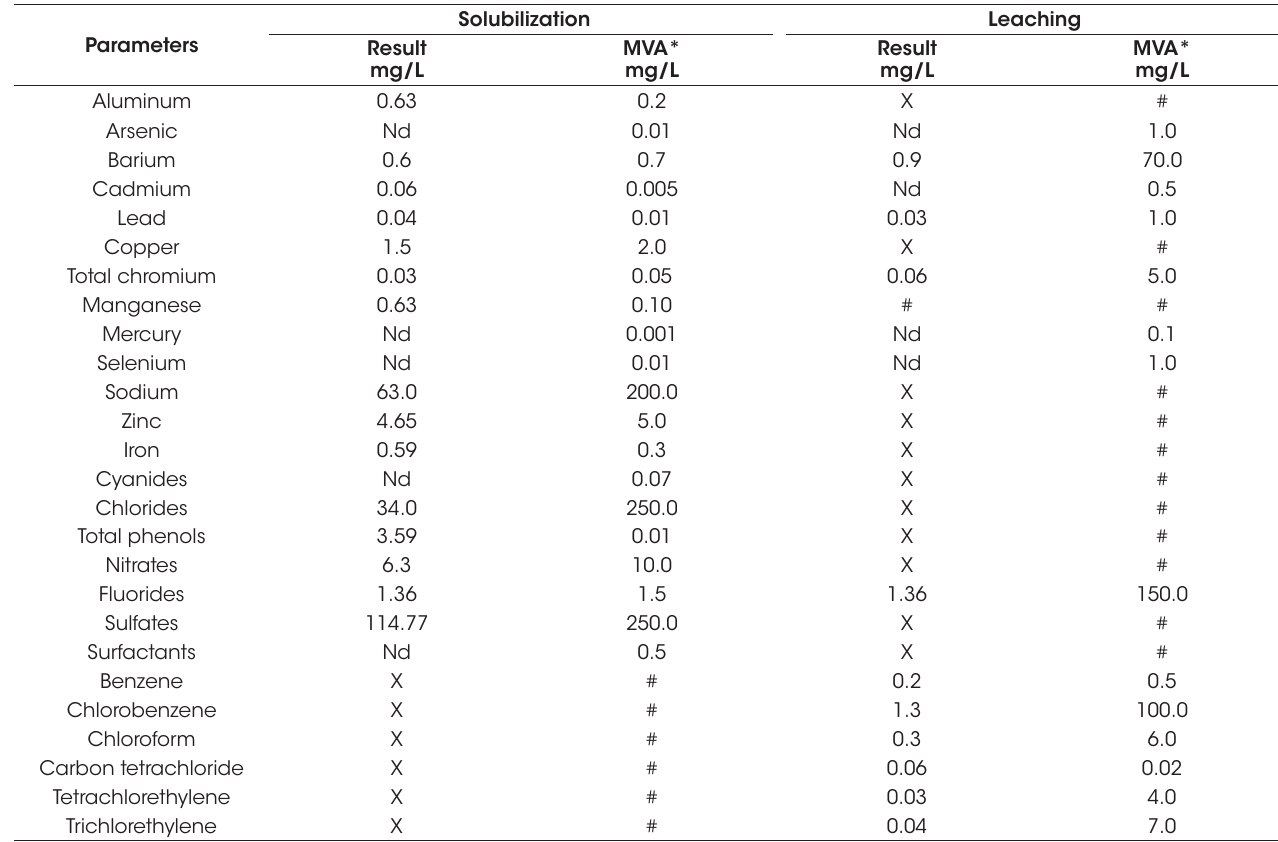
Results of the solubilization and leaching tests for the grinding dust, according to NBR 10004:2004, 10005:2004 and